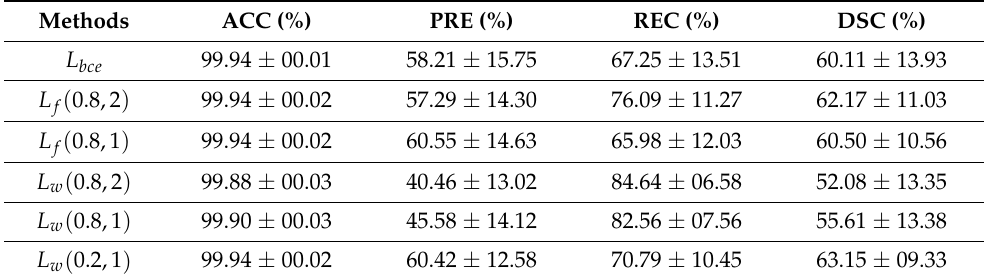
Table 6. ACC, PRE, REC, and DSC comparison of the segmentation with different loss function (compared with the manual ground truth).